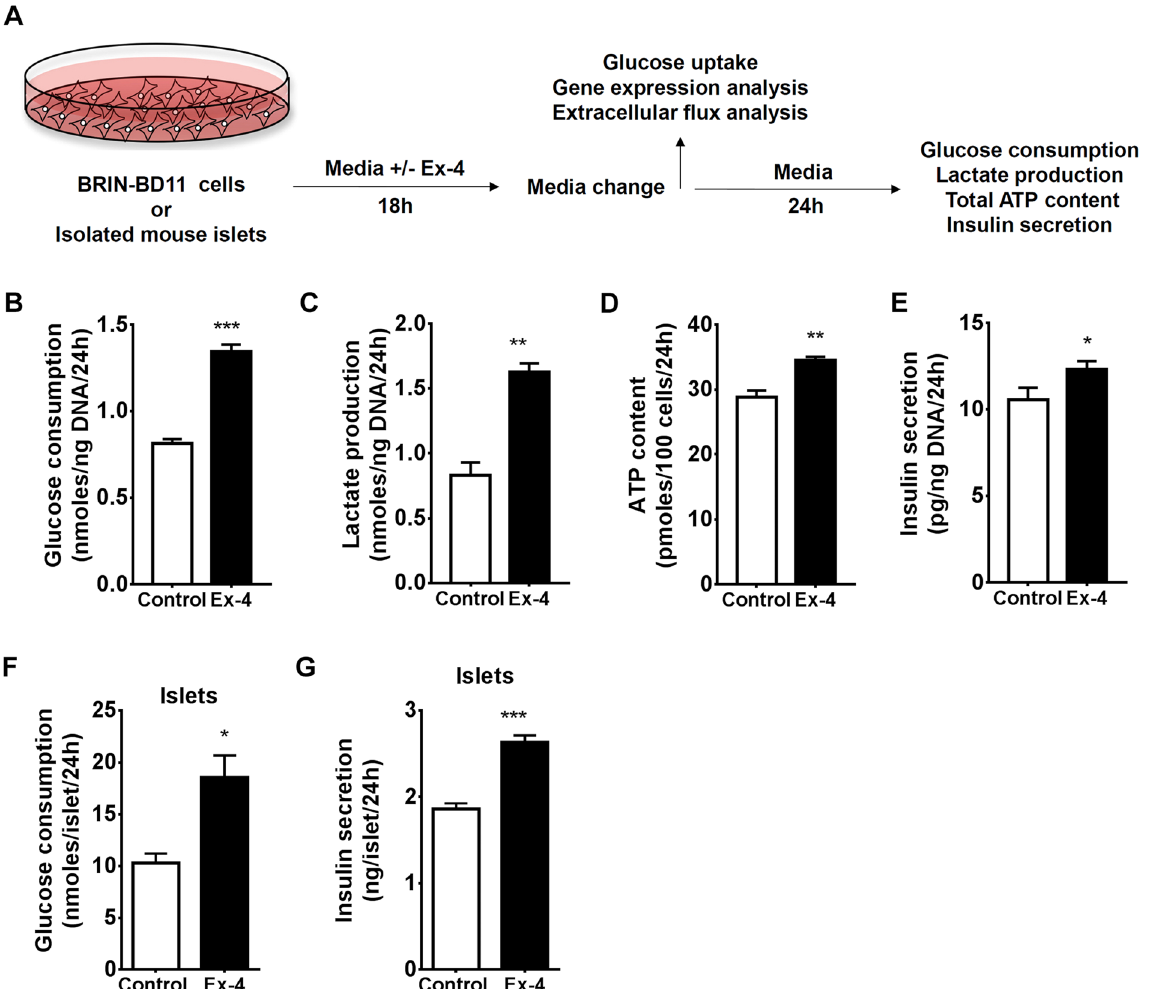
Figure 1. Chronic GLP-1R signalling stimulates β -cell glycolytic metabolism and function. ( A ) Schematic diagram outlining experimental procedures. ( B ) Glucose consumption, ( C ) lactate production, ( D ) ATP content, and ( E ) insulin secretion were assessed in BRIN-BD11 cells. ( F ) Glucose consumption and ( G ) insulin secretion were assessed in murine islets. Data represent mean ± SEM, n ≥ 3; * P < 0.05; ** P < 0.01; *** P <